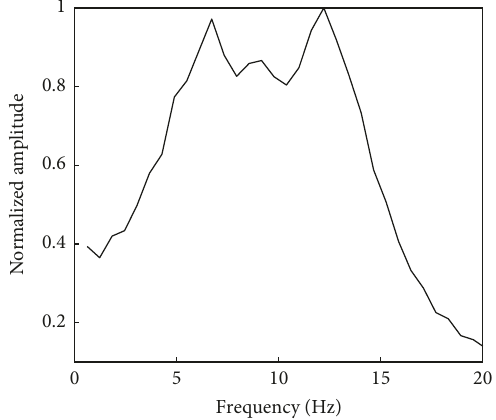
Figure 5: Normalized frequency spectrum of the emission signal